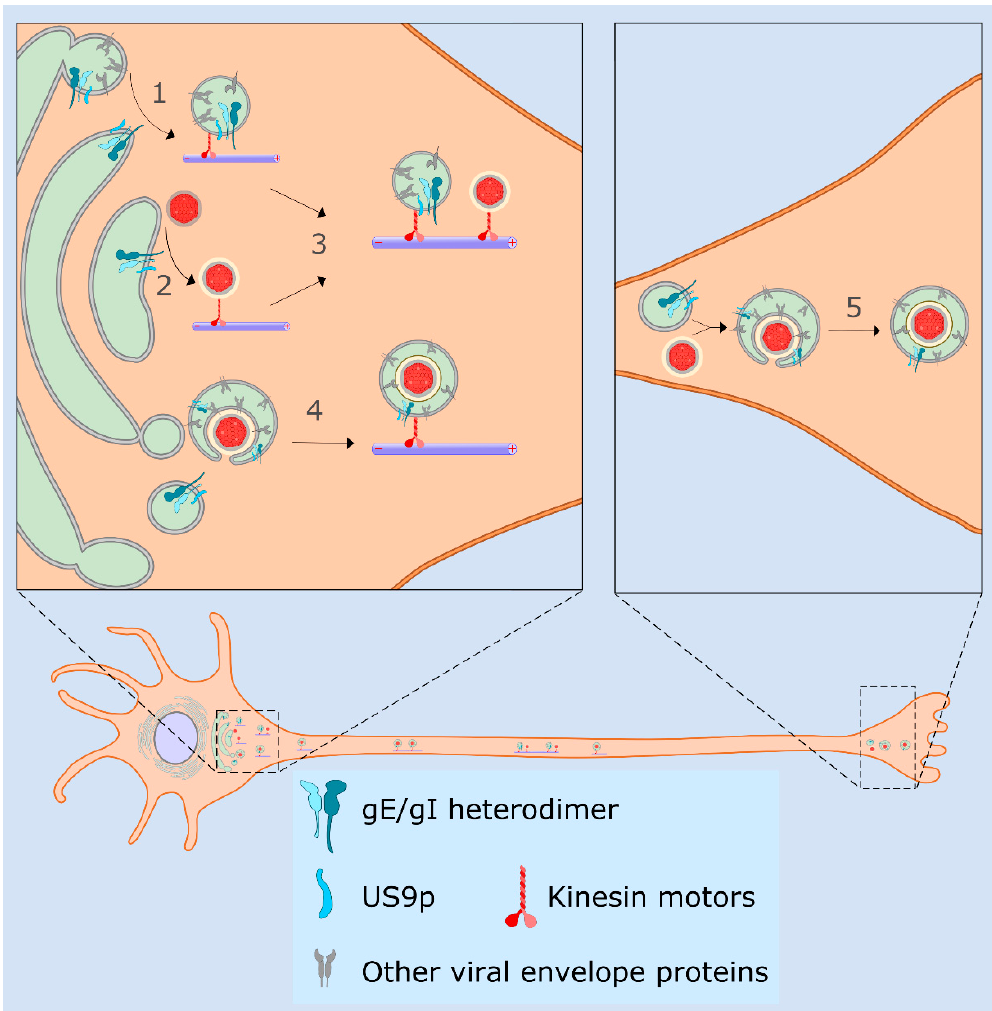
Figure 3. Models for gE/gI-US9p-mediated sorting of HSV-1 during egress in neurons. In the “separate” model, transport vesicles carrying envelope protein cargo recruit kinesin motors using a gE/gI and/or US9p-dependent mechanism (1). Similarly, gE/gI and US9p “load” kinesin motors onto the surface of the HSV-1 capsid shell (2). Since gE/gI and US9p are imbedded in lipid bilayers this process is hypothesized to occur on the cytoplasmic face of an organelle (2), but the mechanism is not well understood. Capsids and transport vesicles then utilize these motors to traffic along cell body and axonal MTs (3) to the nerve terminal, and come together during capsid envelopment to generate the OEV (5). In the “married” model, HSV-1 capsids envelope at cytoplasmic organelles in the neuronal cell body (4) to generate the OEV, much as in non-neuronal cells (Figure 2). gE/gI and US9p may help drive this envelopment and/or subsequently function as membrane-bound receptors to recruit kinesins to the surface of the OEV. The OEV then traffics into and along the axon to transport its cargo of enveloped HSV-1 particles to the nerve terminal. The structures of gE/gI and US9p are represented at the bottom of the figure. Other viral and cellular components are as shown in Figures 1 and 2. See text for more